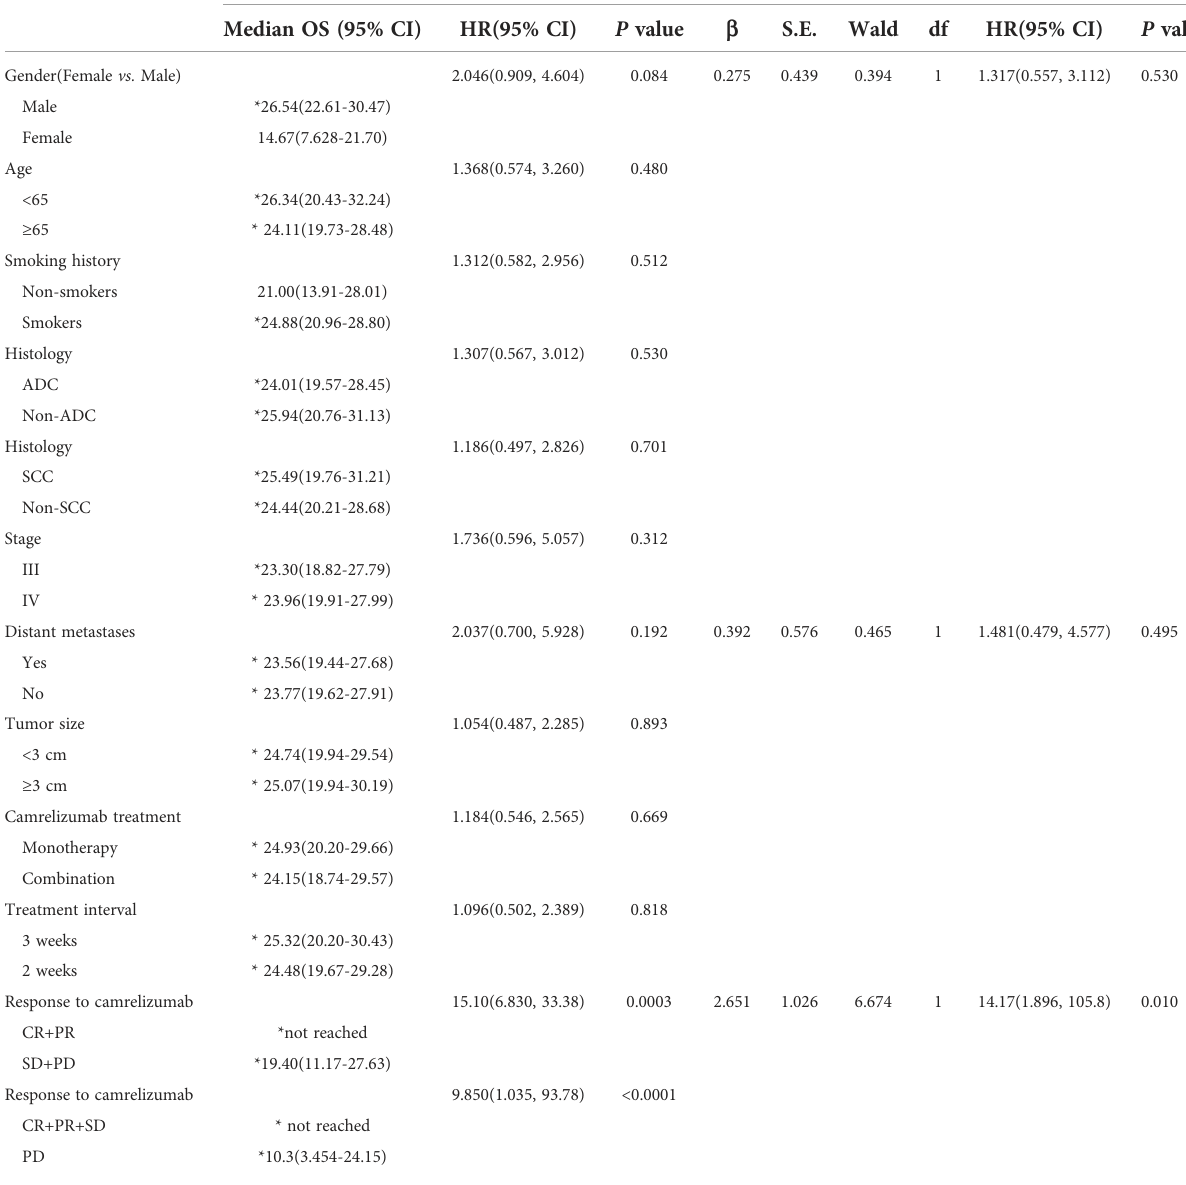
TABLE 5 The univariate and multivariate analyses of overall